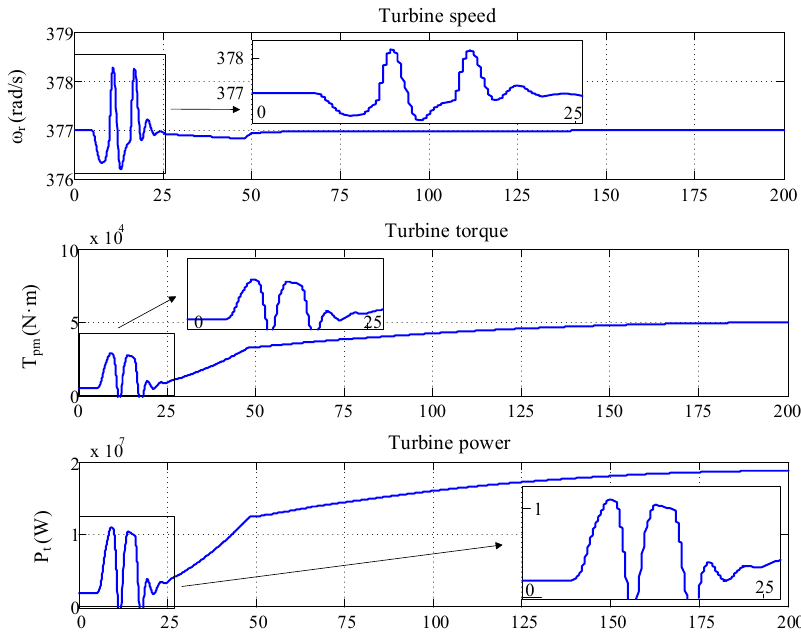
Figure 11. Case 2 gas turbine speed, torque, and power.